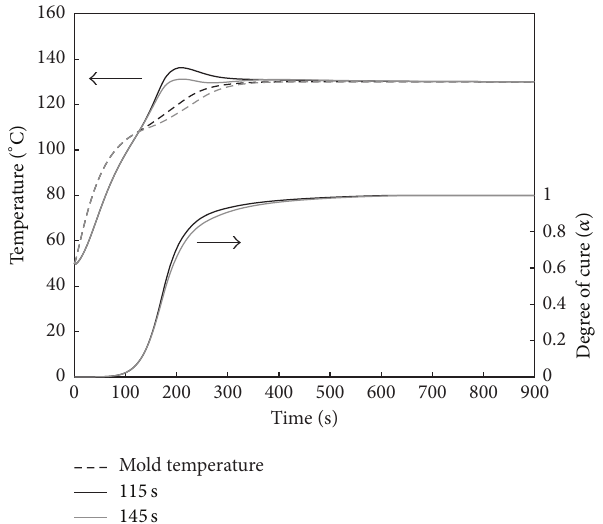
Figure 14: Cure profile of silicone resin decreasing dwell time ( 𝑑𝑡 2 ).